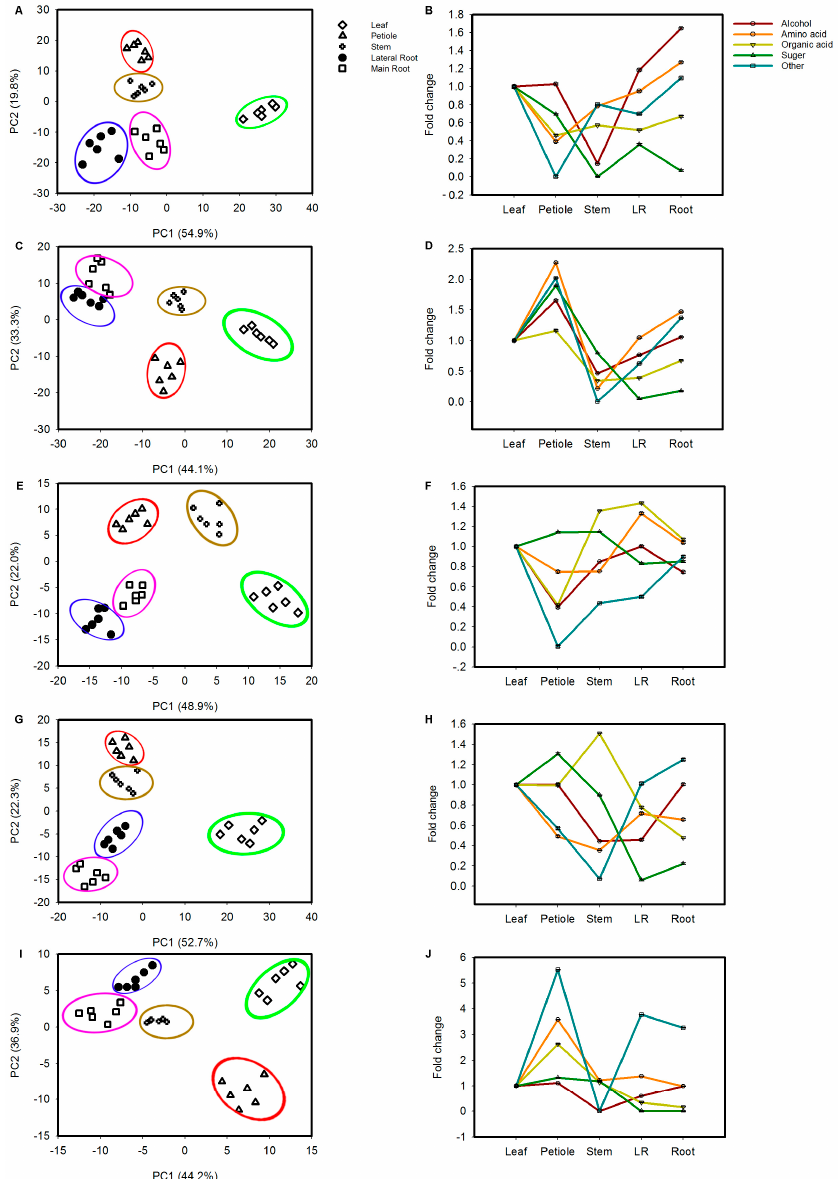
Figure 3. Metabolic alterations in five tissues during developmental. Ginseng samples of five developmental stages 1-, 2-, 3-, 4- and 5-year old were collected for metabolite analysis by GC-MS. ( A , C , E , G , I ) PLS-DA analysis of 1-, 2-, 3-, 4- and 5-year from leaf, petiole, stem, lateral root and root, respectively; ( B , D , F , H , J ) Fold change of alcohol, amino acid, organic acid, sugar and other metabolites in 1-, 2-, 3-, 4- and 5-year at five tissues. The data represent the mean ± standard error of the mean values for six biological replications.